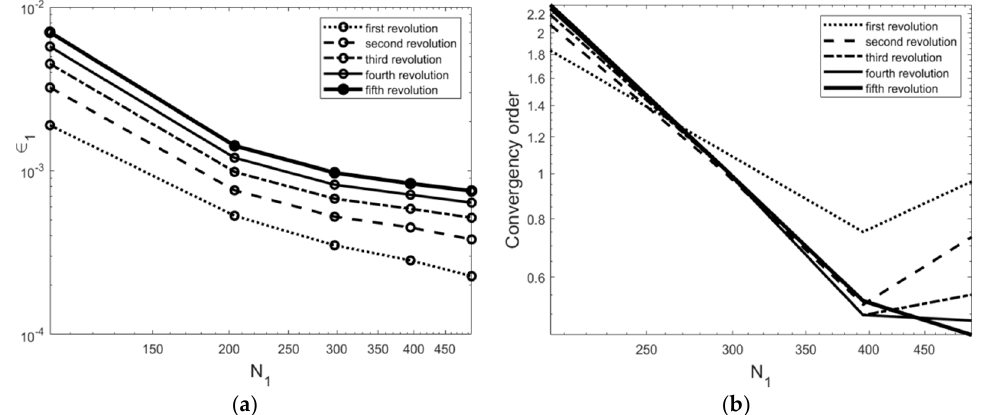
Figure 14. ( a ), The values of the 𝜖 (cid:2869) norm during the revolutions for various structured mesh spacing, ( b ), The values of the convergency order during the revolutions for various structured mesh spacing.